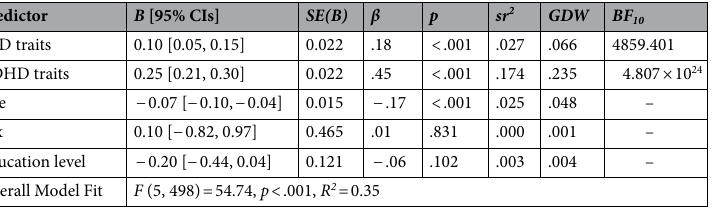
Table 4. Multiple Regression, Dominance, and Bayesian Analyses for Depression . 95% bias-corrected and accelerated bootstrap confidence intervals for B using 2000 resamples. General Dominance Weight (GDW, with higher values indicating a more important predictor). Sex is coded as 0 = female; 1 =